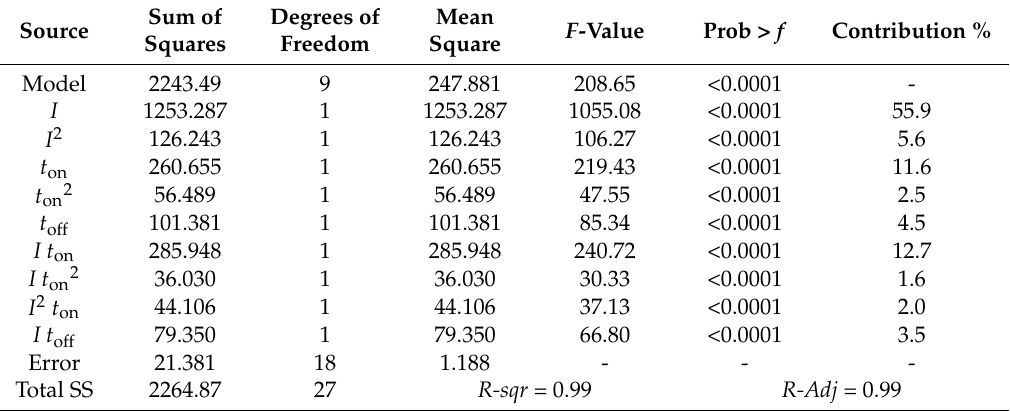
Table 8. The ANOVA table for the material removal rate (MRR) (after